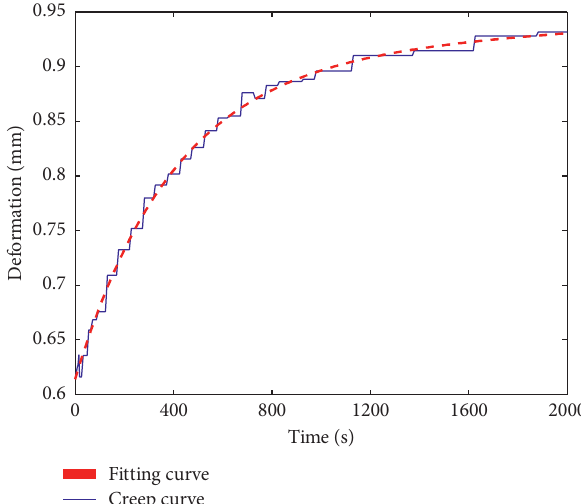
Figure 1: Curve fitting result of creep